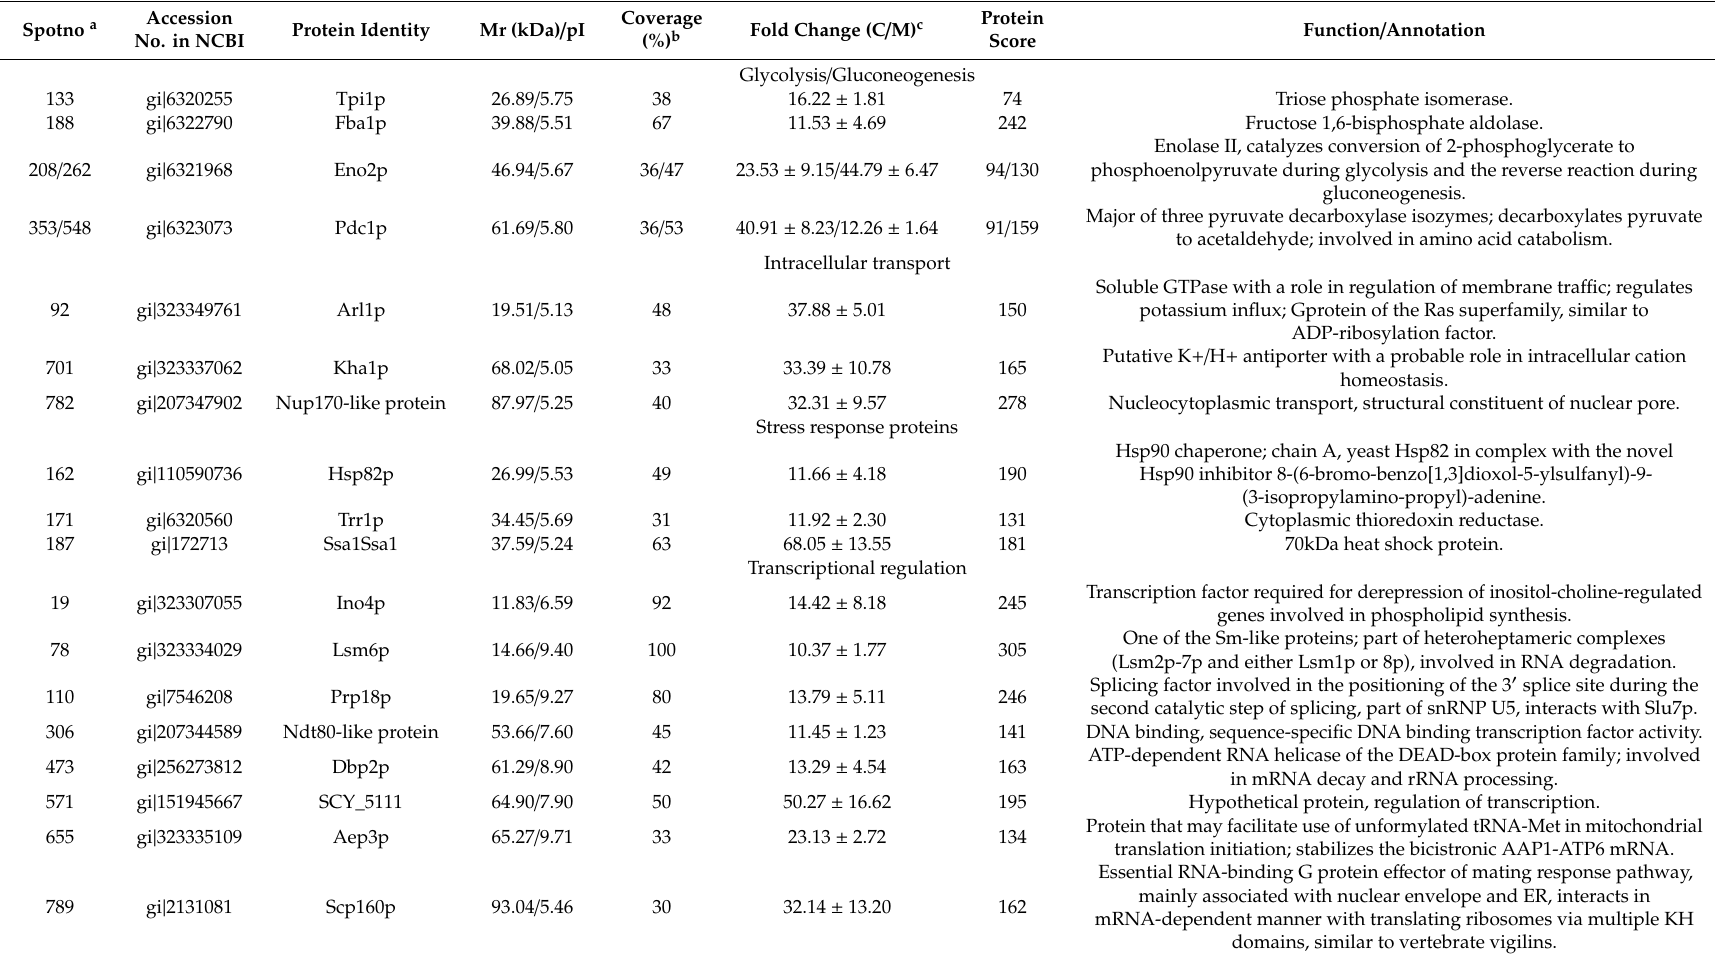
Table 1. Down-regulated proteins identified after knock-out of the Pep4 gene in S. cerevisiae.